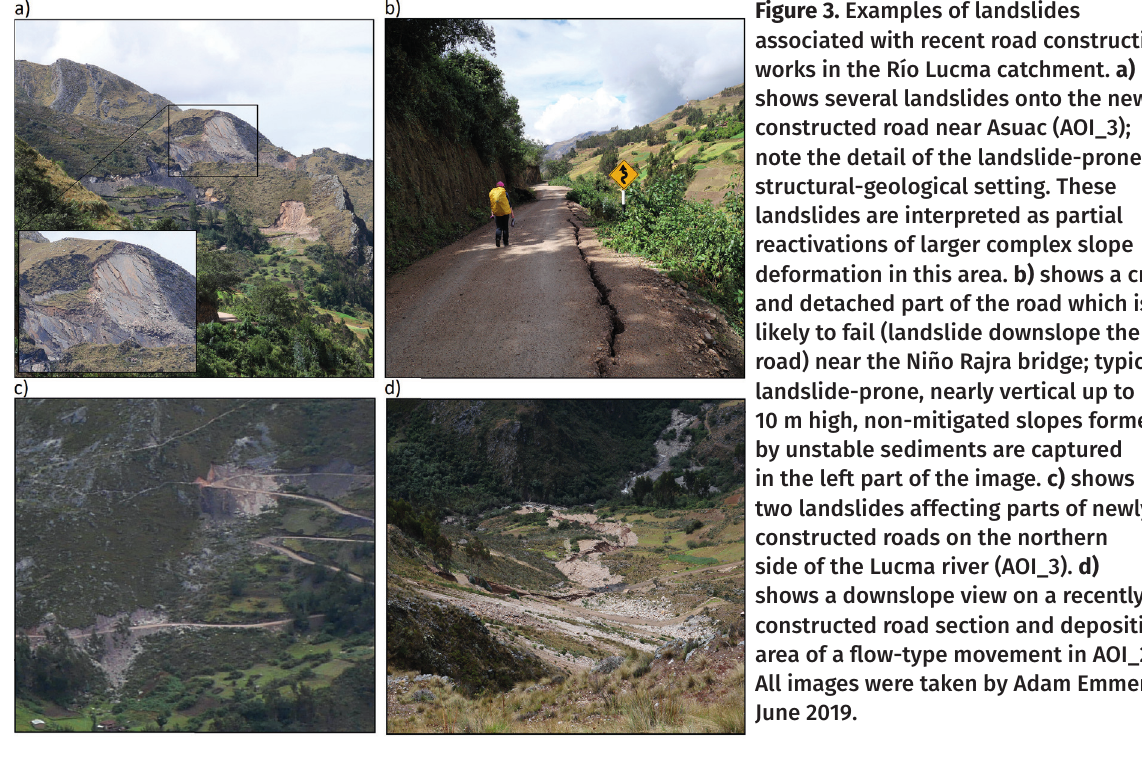
Figure 3. Examples of landslides associated with recent road construction works in the Río Lucma catchment. a) shows several landslides onto the newly constructed road near Asuac (AOI_3); note the detail of the landslide-prone structural-geological setting. These landslides are interpreted as partial reactivations of larger complex slope deformation in this area. b) shows a crack and detached part of the road which is likely to fail (landslide downslope the road) near the Niño Rajra bridge; typical landslide-prone, nearly vertical up to 10 m high, non-mitigated slopes formed by unstable sediments are captured in the left part of the image. c) shows two landslides affecting parts of newly constructed roads on the northern side of the Lucma river (AOI_3). d) shows a downslope view on a recently constructed road section and deposition area of a fl ow-type movement in AOI_2. All images were taken by Adam Emmer in June